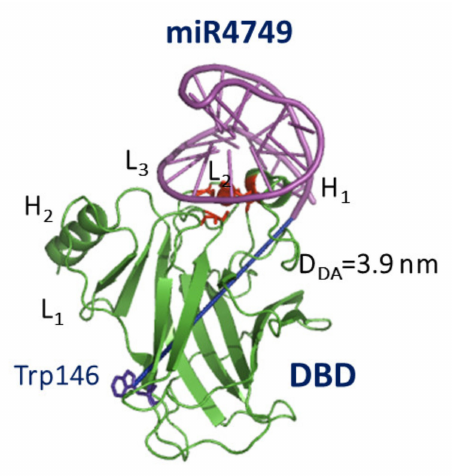
Figure 4. Graphical representation of the best model for the complex between DBD (green) and miR4749-5p (magenta). The initial structure of DBD was taken from the chain B of 1TUP PDB entry, while that of miR4749-5p is the model in Figure 3B). The distance D DA between the center of the aromatic rings of Trp146 and the 5 (cid:48) end of miR4749-5p is marked as a blue line. Adapted from ref. [70].